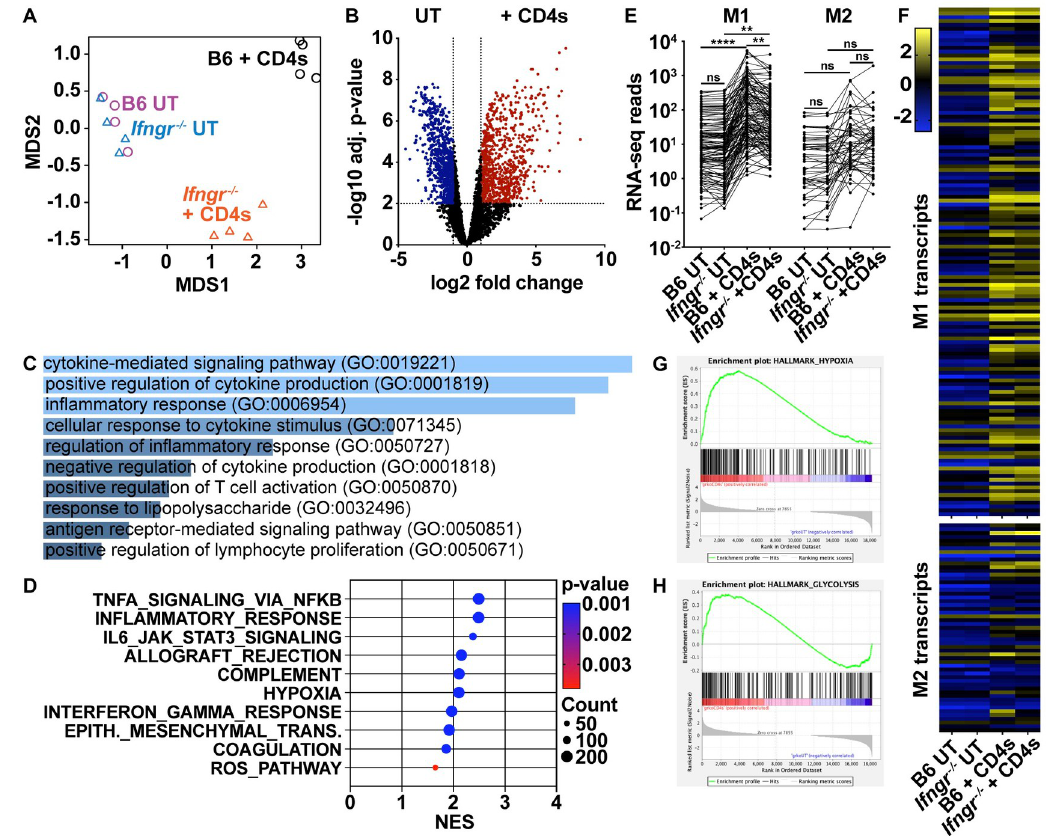
Fig 2. IFN- γ is not required for T cell-mediated macrophage activation and polarization during M . tuberculosis infection. ( A )-( B )RNA-seq at 24 h postinfection for wild-type and Ifngr -/- BMDMs co-cultured with lung-derived CD4 T cells. (A) Principal component analysis plot, (B) Volcano plot of genes in Ifngr -/- BMDMs with > 2-fold change in gene expression and adj. p-value > 0.05 following cell co-culture. ( C ) Top ten enriched ontology clusters from Ingenuity Pathway Analysis of genes with > 2-fold upregulation in both wild-type and Ifngr -/- BMDMs following co-culture. ( D ) Top ten enriched gene sets from the MSigDB H: Hallmark collection from Ifngr -/- BMDMs following co-culture. ( E )-( F ) RNA-seq reads (E) and heat map (F) of M1- or M2-associated transcripts. ( G )-( H ) Gene Set Enrichment Analysis plots of (G) Hypoxia or (H) Glycolysis gene sets in Ifngr -/- BMDMs following co-culture. Figures represent data from four replicate experiments, �� p < 0.01, ���� p < 0.0001 by Tukey post hoc